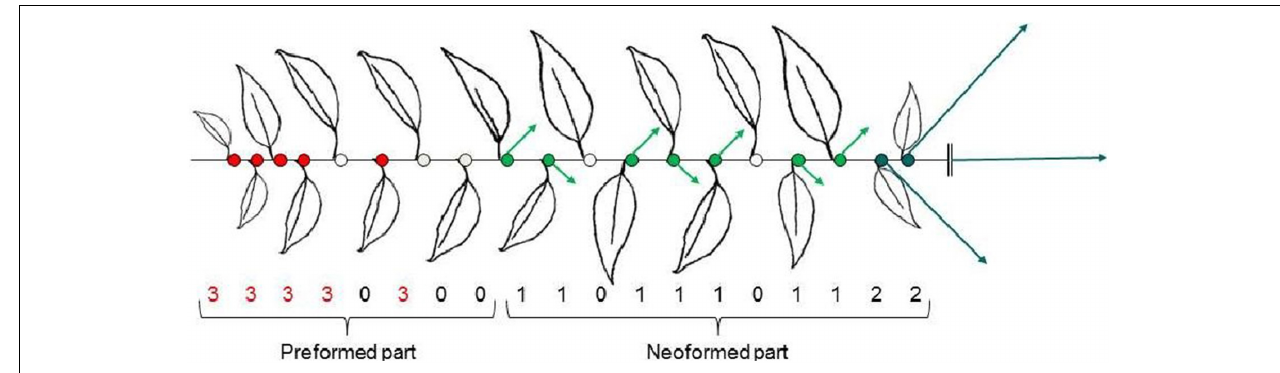
exclusively on the preformed nodes of the previous year